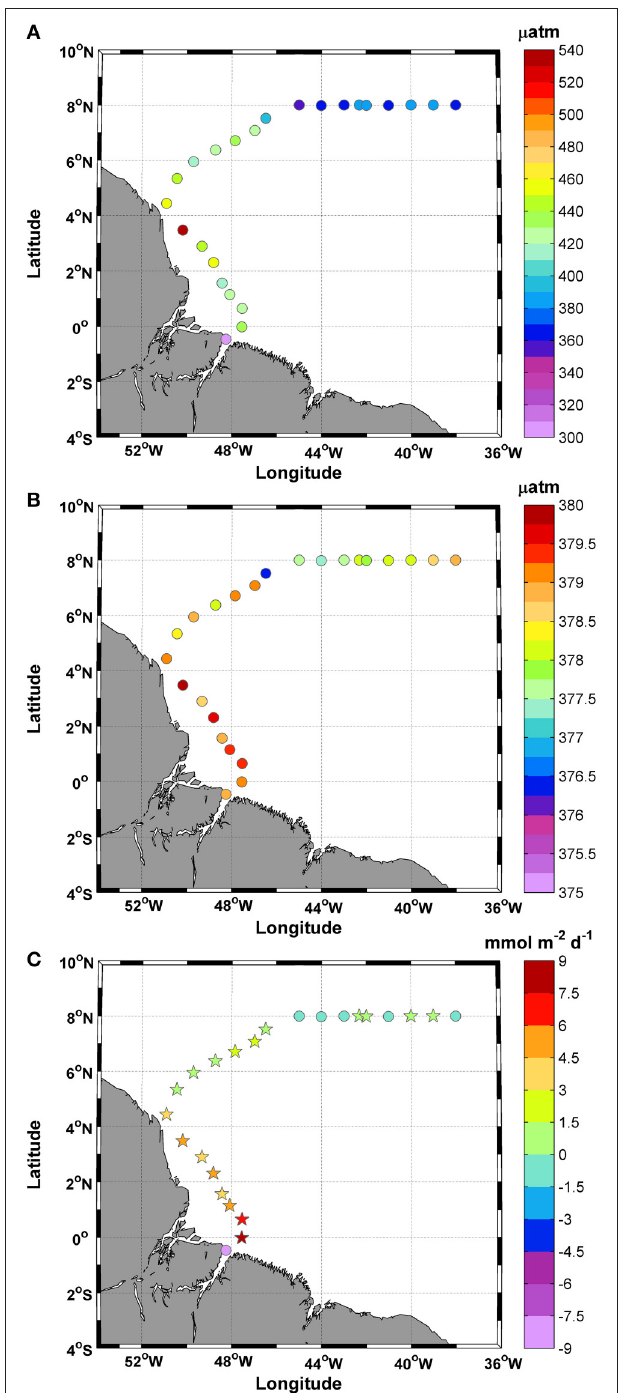
FIGURE 6 | Distributions of (A) fCO 2 sw; (B) fCO 2 atm; and (C) Calculated CO 2 fluxes along the ship track during the CF3 cruise, October 2012. The circle and star symbols in 6C indicate negative and positive values,